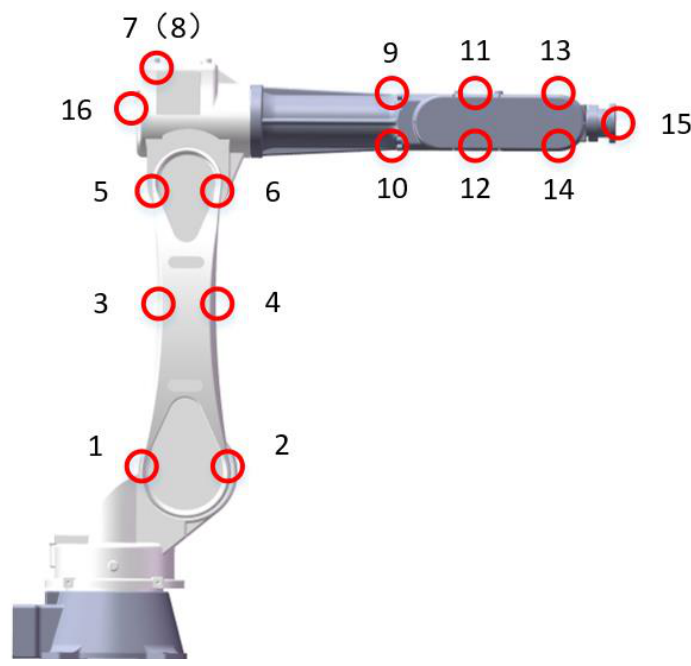
Figure 3. Selection of initial sensor placement.